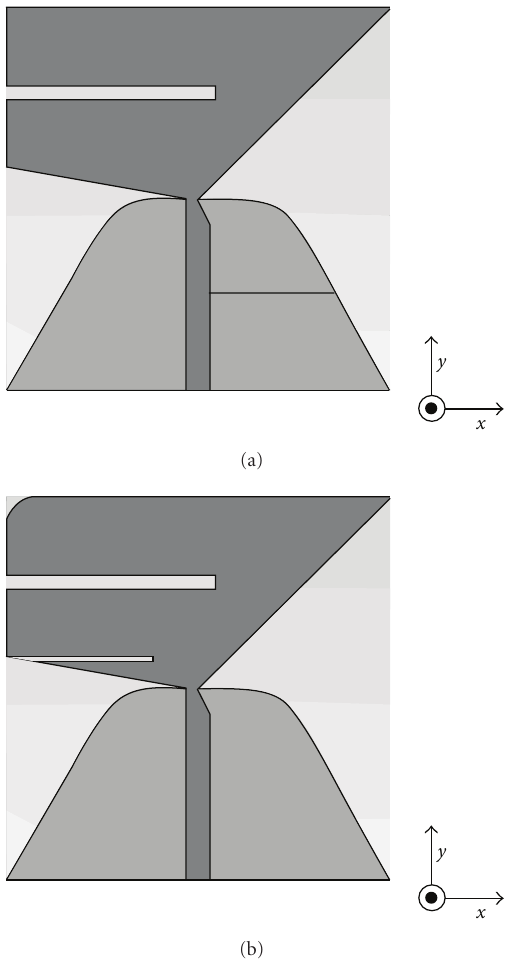
Figure 4: The geometries of the proposed antennas: (a) dual band- notched antenna 1, (b) dual band-notched antenna